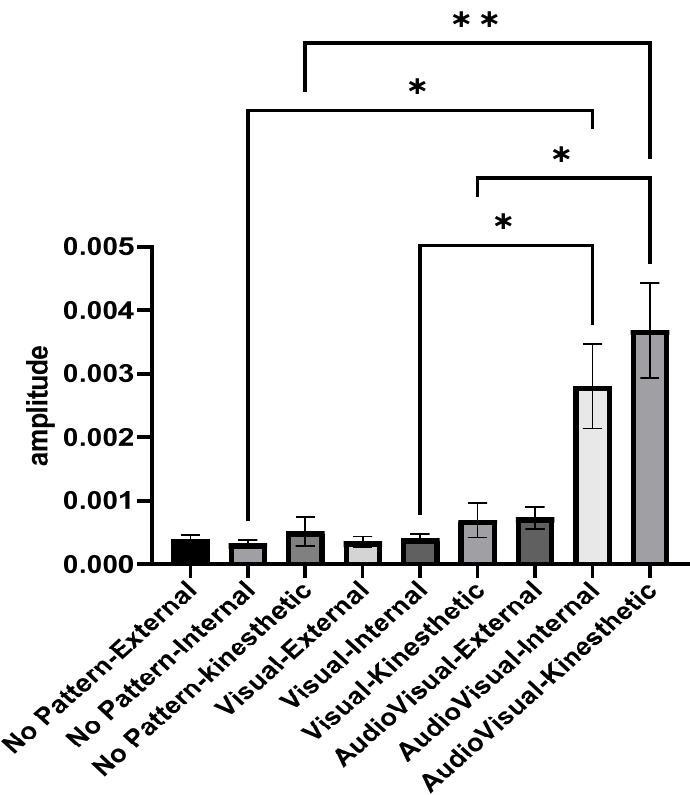
Figure 4. Activity range of elbow extensor muscles in three different conditions of No pattern, Visual pattern, and AudioVisual pattern and in three different perspectives of external, internal, and kinesthetic imagery; * p < 0.05, ** p < 0.01.